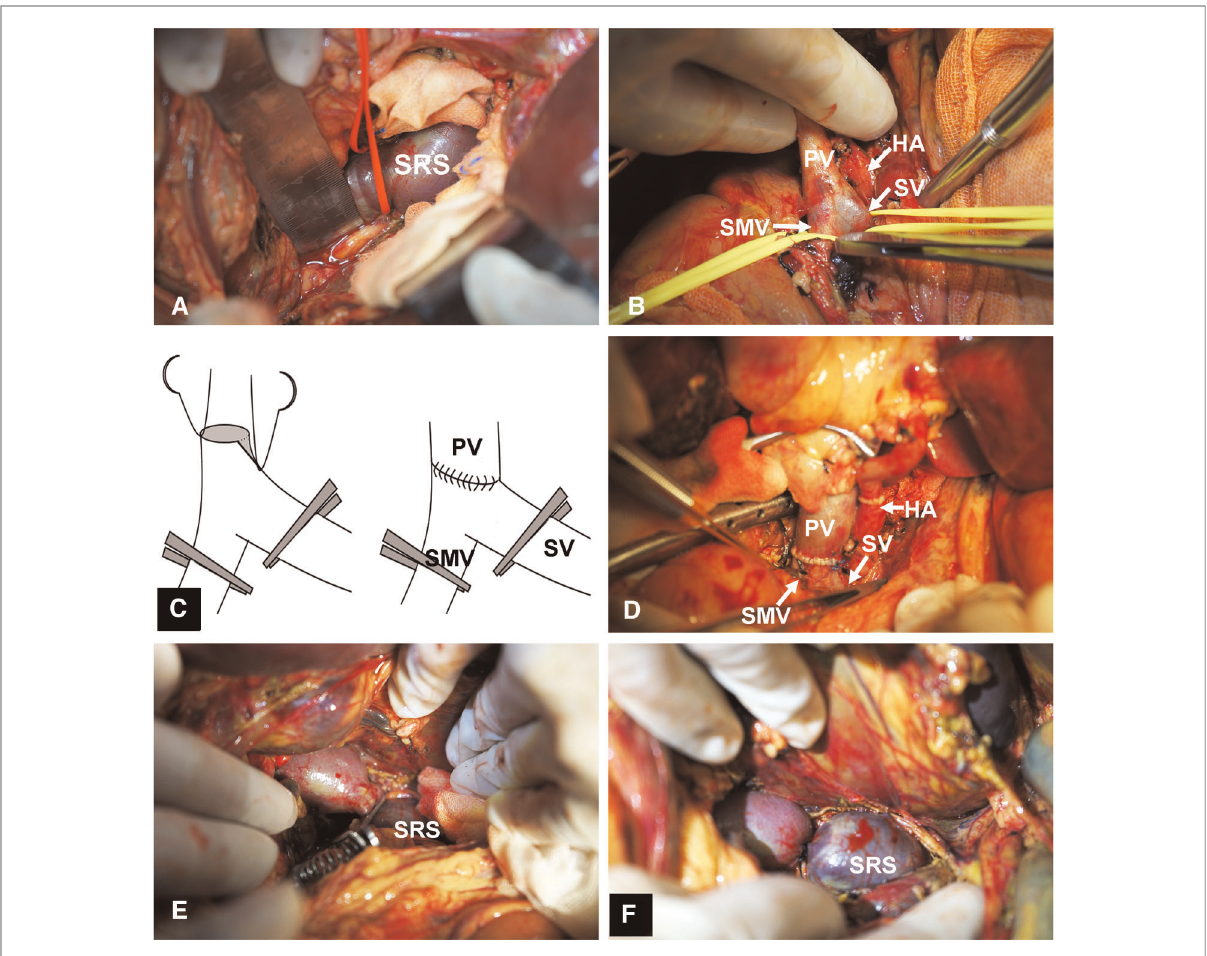
FIGURE 3 Surgical procedure for SRS ligation. ( A ) Identi fi cation and isolation of the large SRS. ( B ) Small diameter of PV,the isolation of SMV, and SV behind the neck of pancreas. ( C ) Angioplasty of the PV. ( D ) Portal vein anastomosis to the con fl uence of SV and SMV with satisfactory results. ( E ) Test clamping of SRS. ( F ) Ligation of SRS. SMV, superior mesenteric